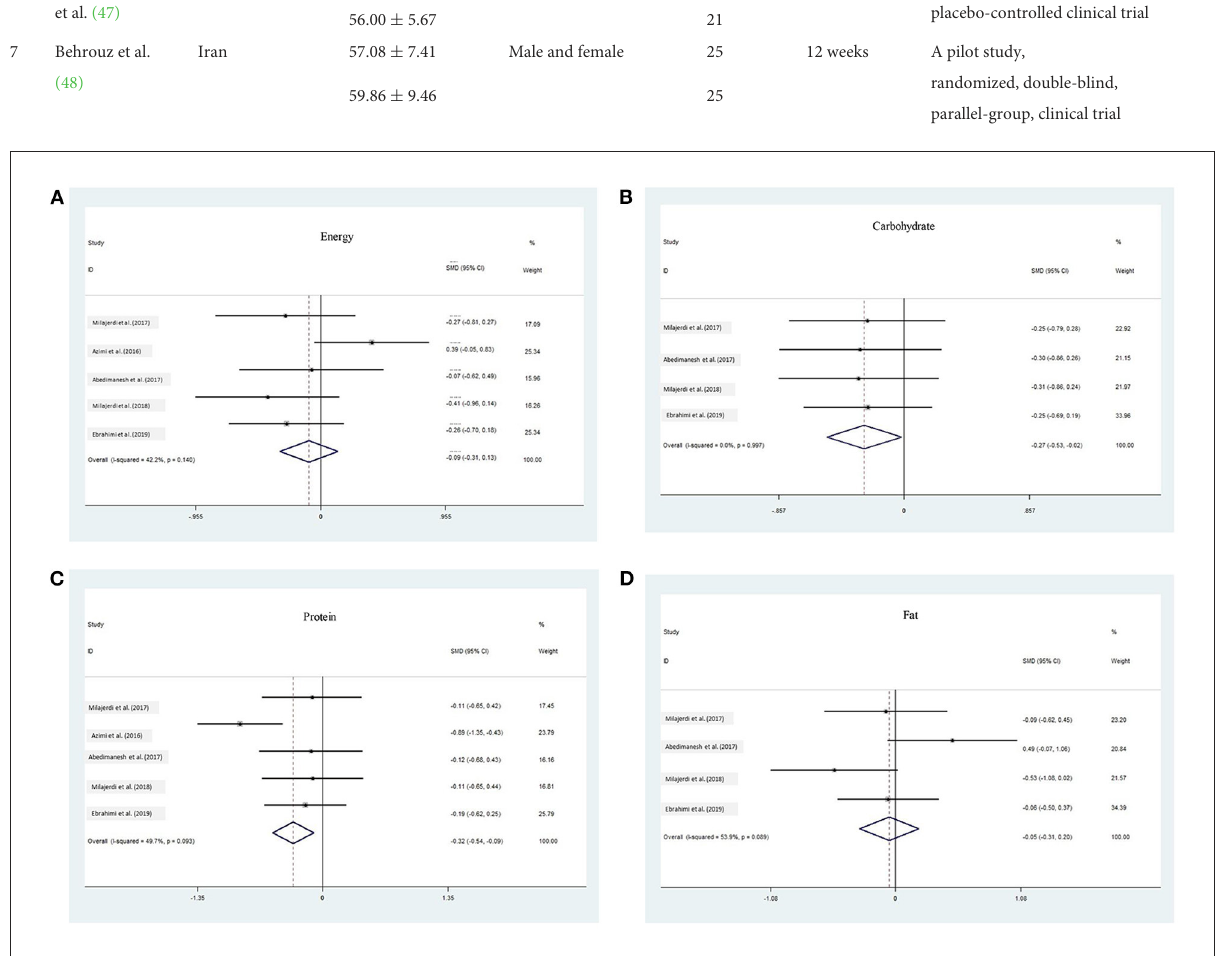
FIGURE2 The association between saffron and (A) Energy, (B) carbohydrate, (C) protein, and (D) fat.